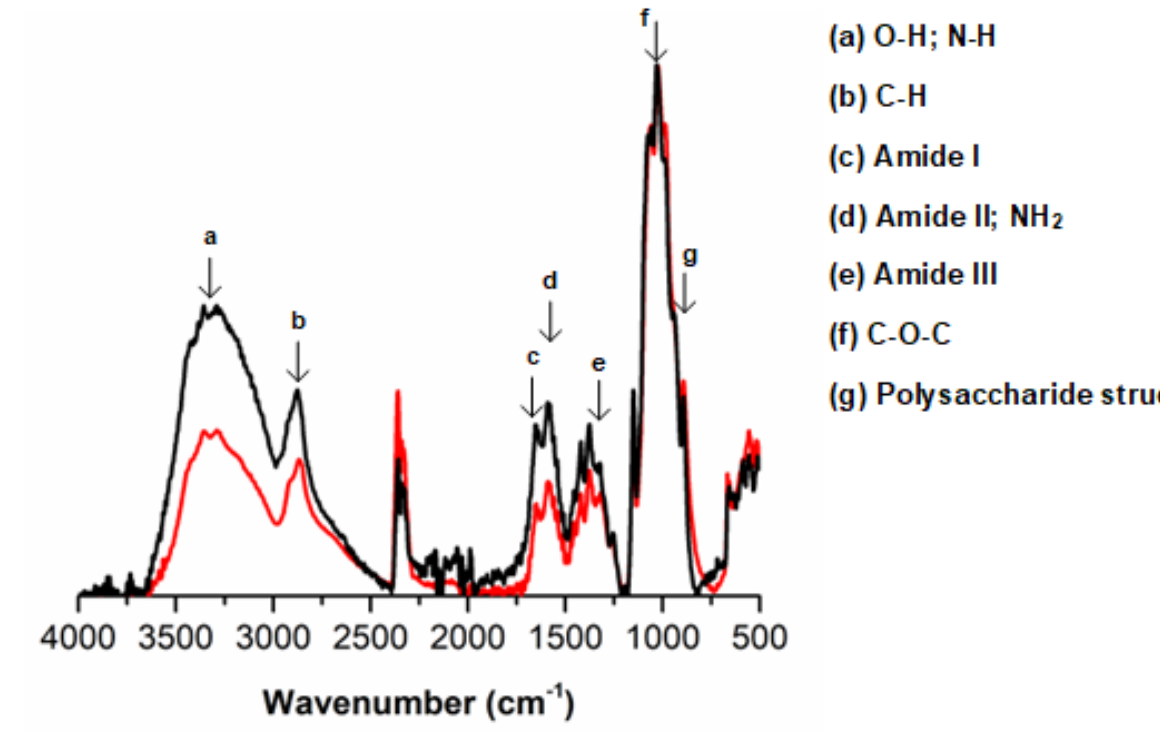
Figure 3. Normalized (at 1027 cm − 1 ) FTIR-ATR spectra of NaOH neutralized CS ( ▬ ) and pristine CS ( ▬ ) samples.